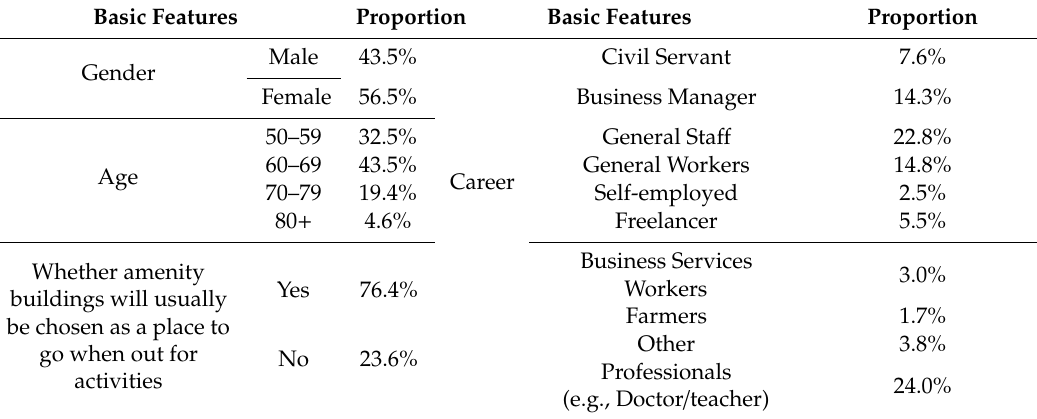
Table 3. Basic demographic features of questionnaire respondents.